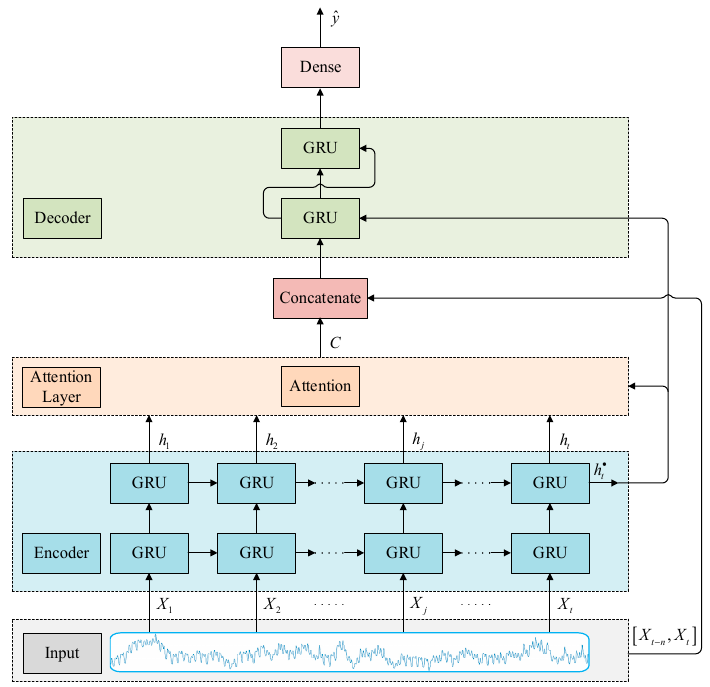
Figure 3. Structural description of attention-based codec prediction